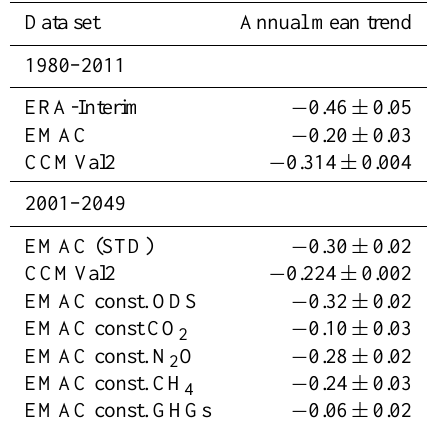
Table 3. Global temperature trends at 50hPa from ERA-Interim re- analyses and model simulations. All values are in Kdecade − 1 with a 2 σ error